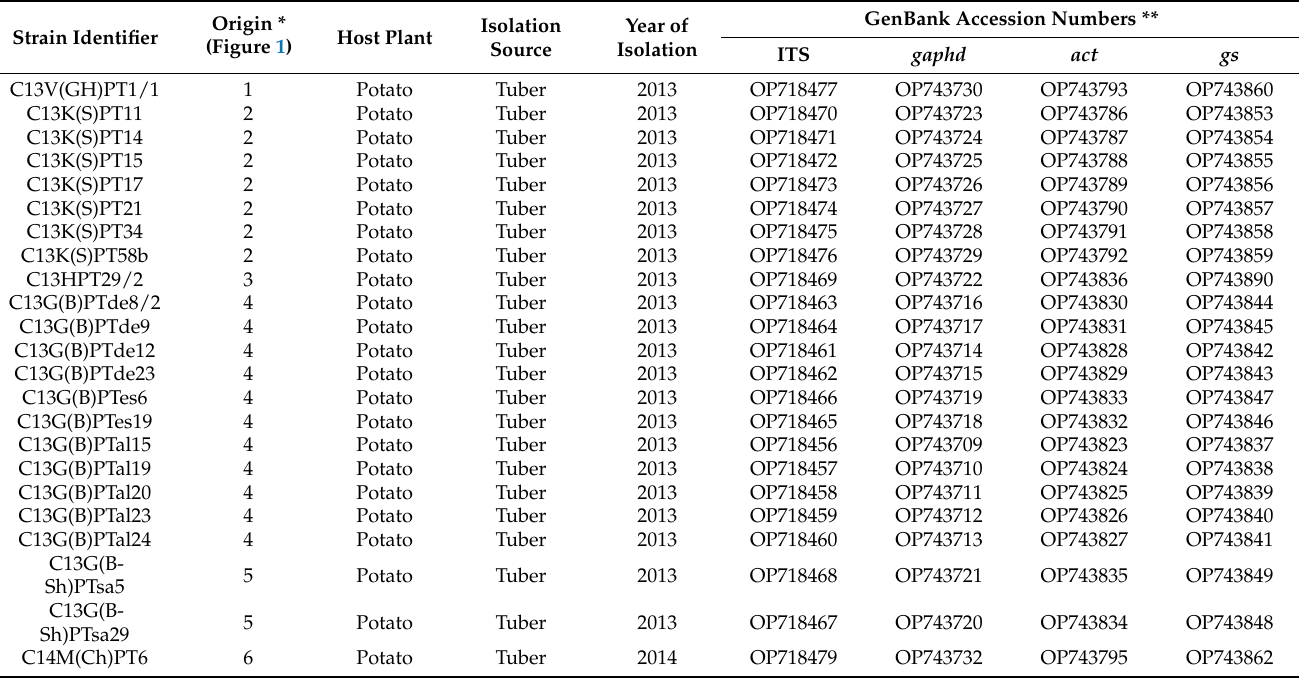
Table 1. Details of isolates used in the